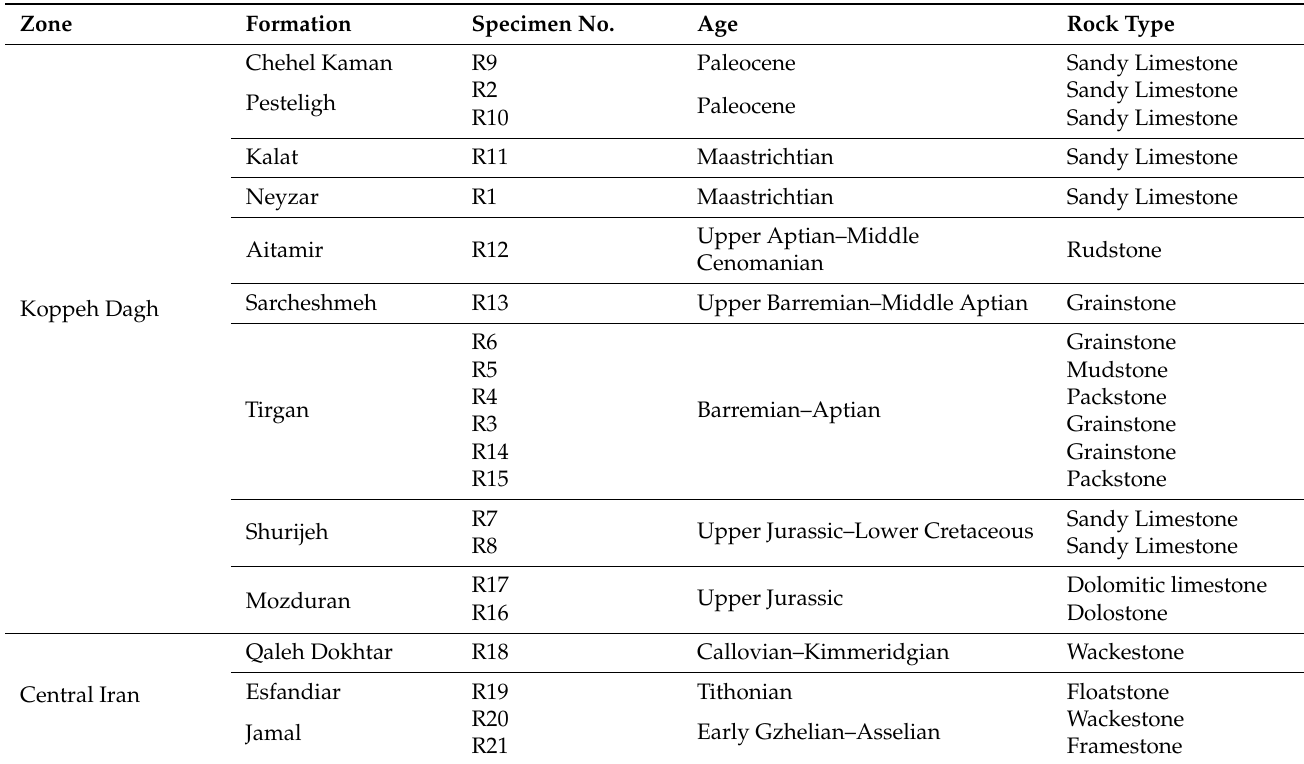
Figure 2. Some photomicrographs of the studied samples: Packstone- R23 ( A ), Grainstone- R13 ( B ), Dolostone- R16 ( C ), and Dolo Mudstone- R28 ( D ). Table 2. Age, sampling zone, and type of rocks.